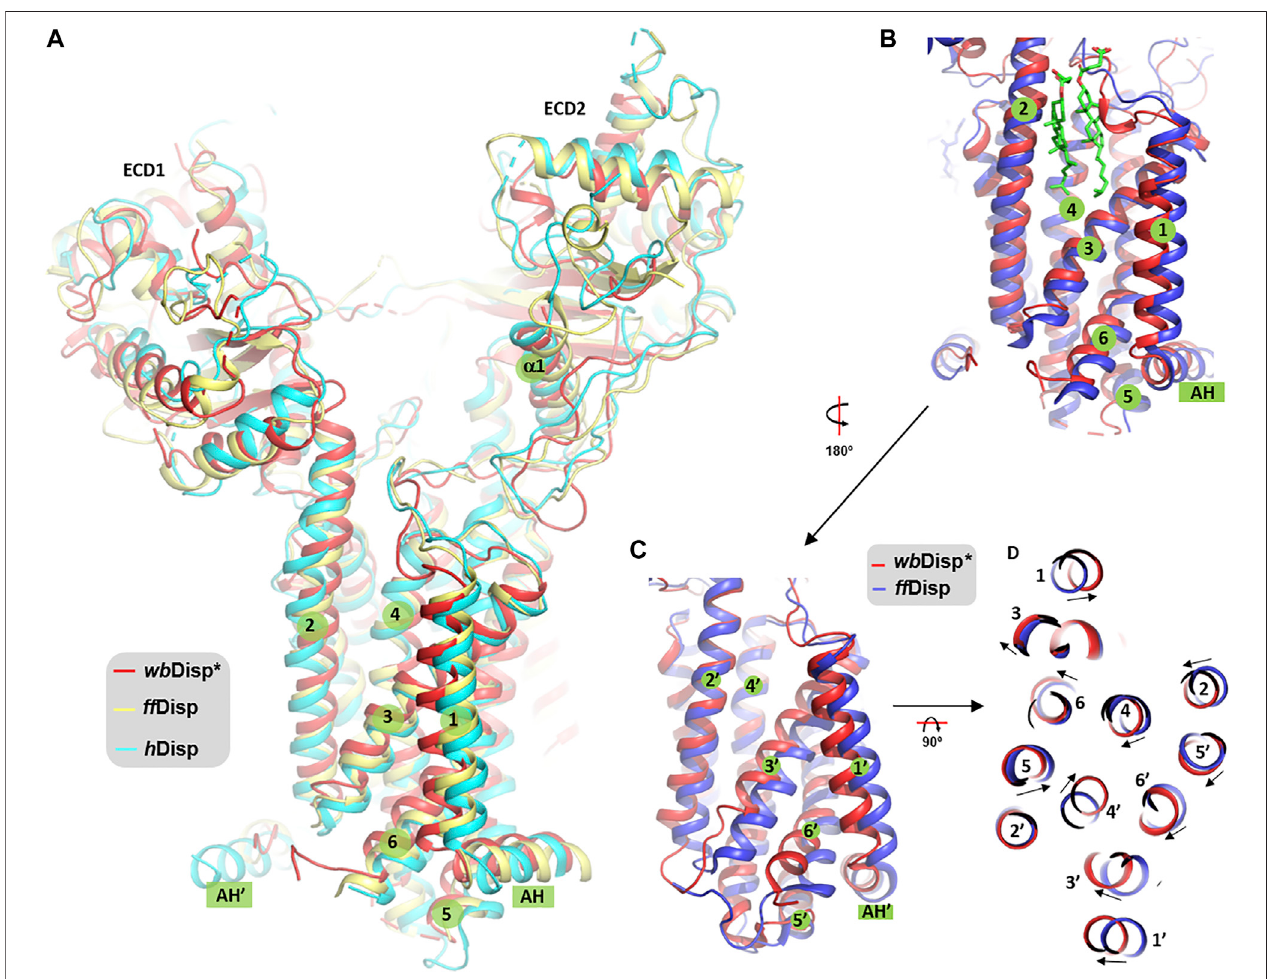
FIGURE 4 | Comparison of Disp structures. (A) The overall view. (B, C) Comparison of TMH 1 – 6 (B) and TMH 7 – 12 (TMH1 ’ -6 ’ ) (C) of wb Disp (red) with the ff Disp structure (blue). (D) View from the extracellular side. The two sterol molecules in (B) are from the ff Disp structure (PDB ID 6tbu) (Cannac et al., 2020). AH: amphipathic